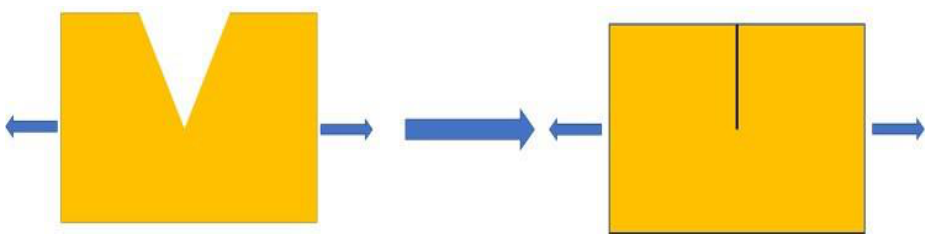
Figure 11. Schematic illustration of opening–closing action of cracks in beams. The relationship of the normalized displacement on the normalized applied force is shown in Figure 12.